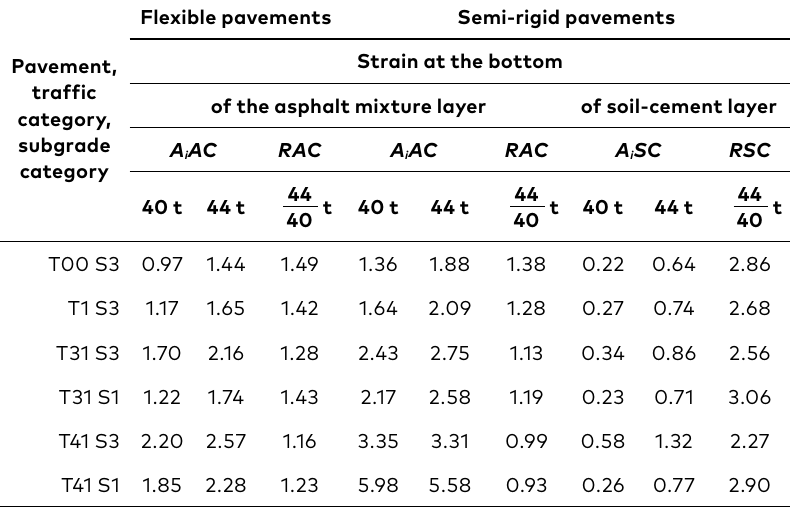
Table 7. Aggressiveness coefficients ratio between a heavy vehicle with 44 t and 40 t. Hypothesis